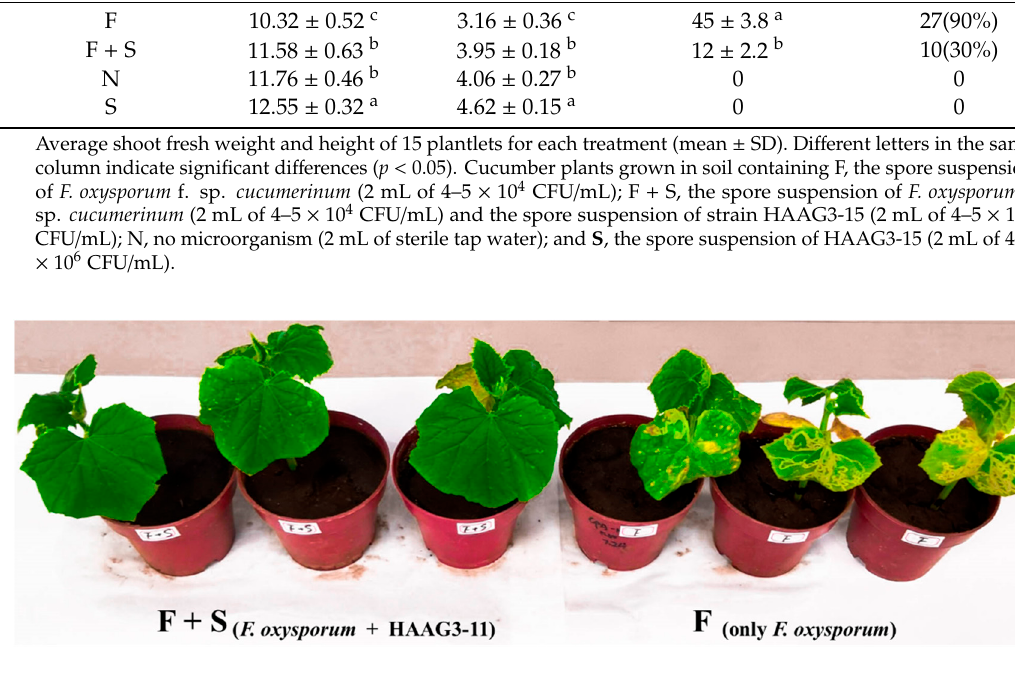
Figure 8. Biocontrol assay of inoculation with F. oxysporum f. sp . cucumerinum and strain HAAG3-15 on cucumber seedlings in greenhouse. Inoculation with F. oxysporum f. sp . cucumerinum and HAAG3-15 (left, F + S), and only inoculated F. oxysporum f. sp . cucumerinum (right, F). Table 1. Height, shoot fresh weight, disease index (DI), and number of infected plantlets with four treatments in greenhouse biocontrol assay.